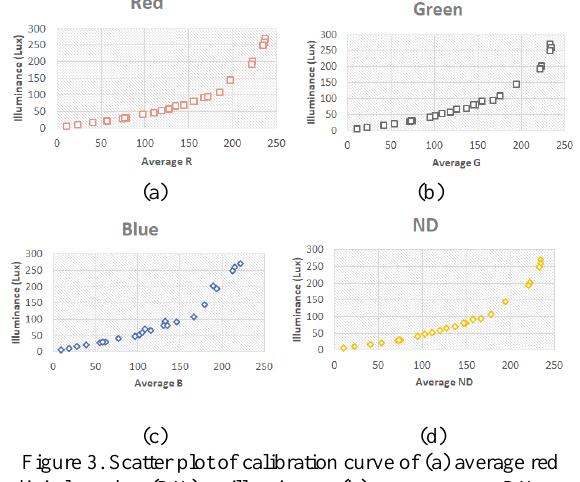
Figure 3. Scatter plot of calibration curve of (a) average red digital number (DN) vs illuminance (b) average green DN vs. illuminance (c) average blue DN vs. illuminance (d) average ND vs. illuminance.